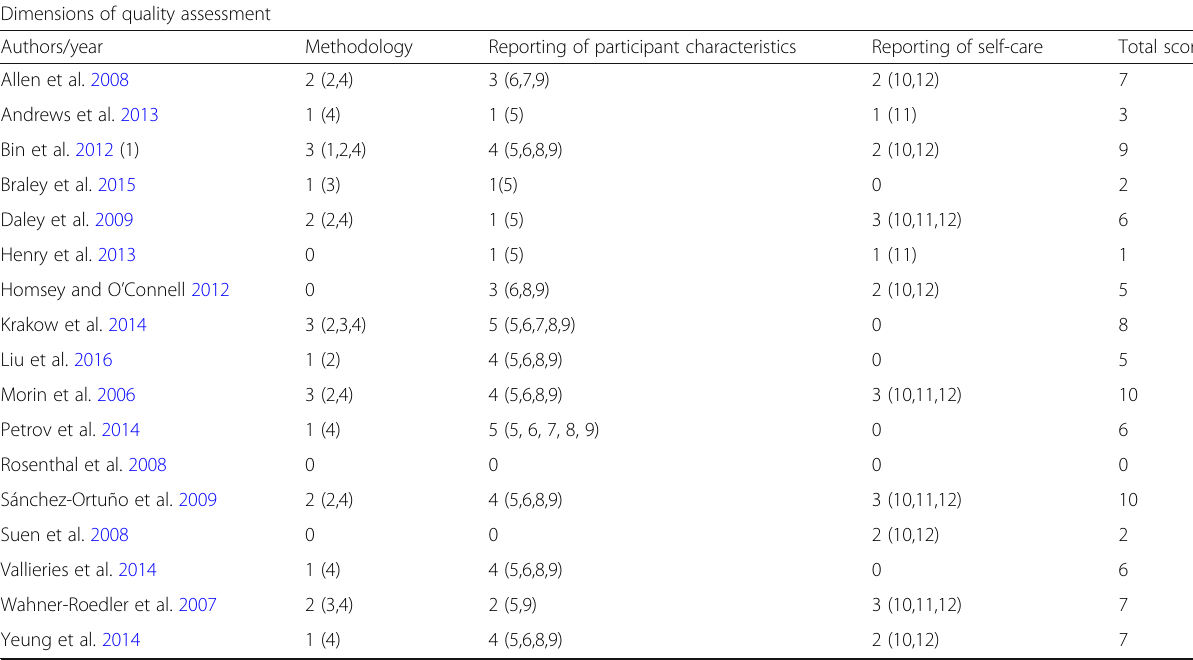
Table 3 Quality scores of studies on self-care for sleep